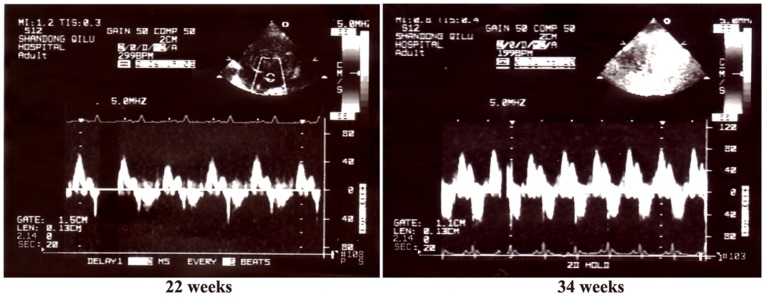
Transmitral inflow patterns (E and A wave) for MS rat at 22 and 34 weeks.Note increased A waves and decreased E/A in the MS group.